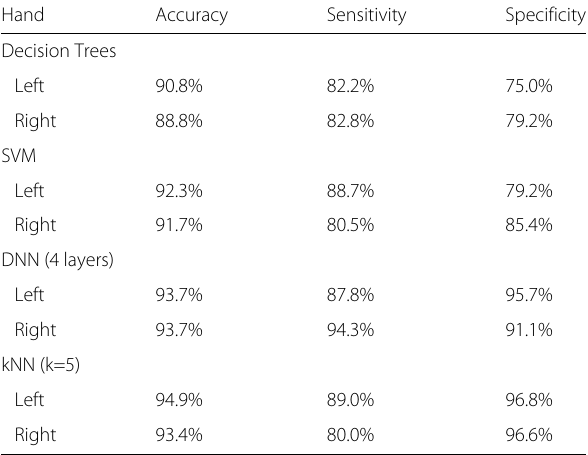
Table 3 Comparison of different ML methods for fall